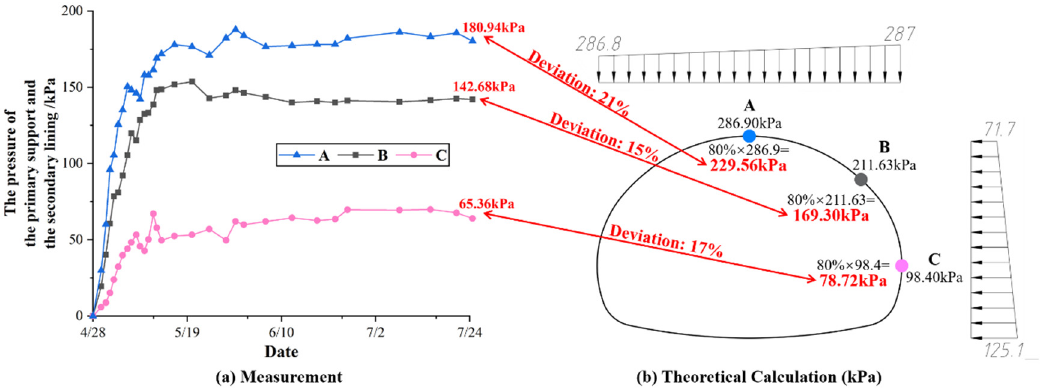
Figure 14. Total pressure of the primary support and the secondary lining. There is about 20% deviation at each point and it is believed to be born mainly by advance support and the surrounding rock itself.